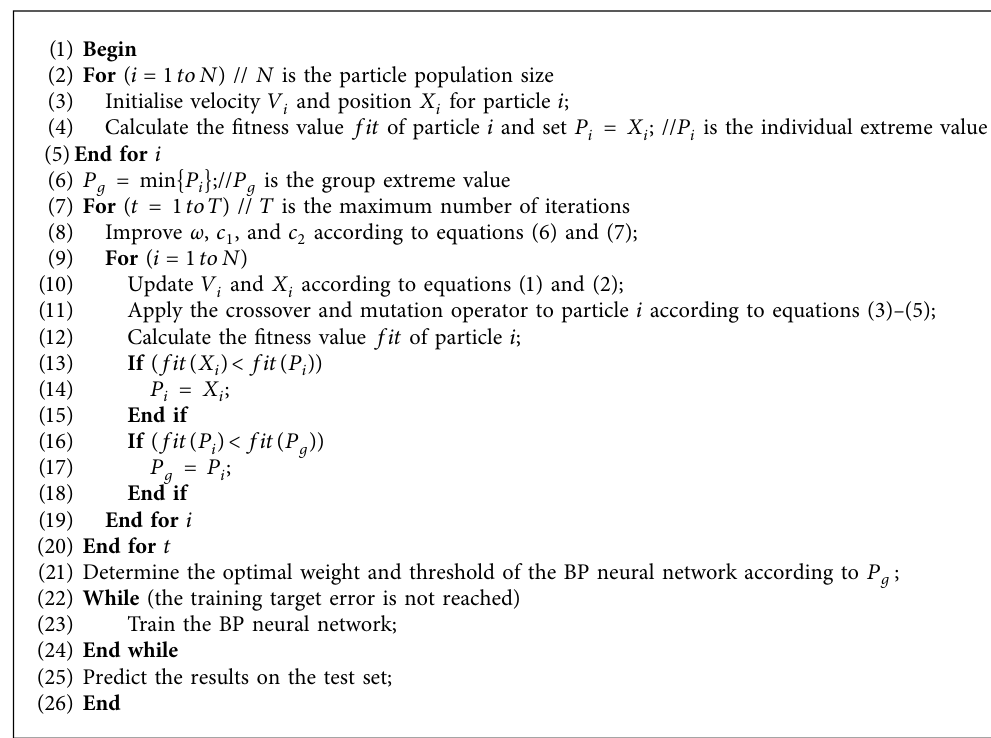
A LGORITHM 1: Pseudocode of improved HPSO-BP